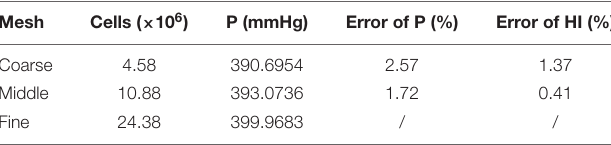
TABLE 4 | Results of grid sensitivity analysis for the portable pump, 5 L/min, 3,500 rpm. Mesh